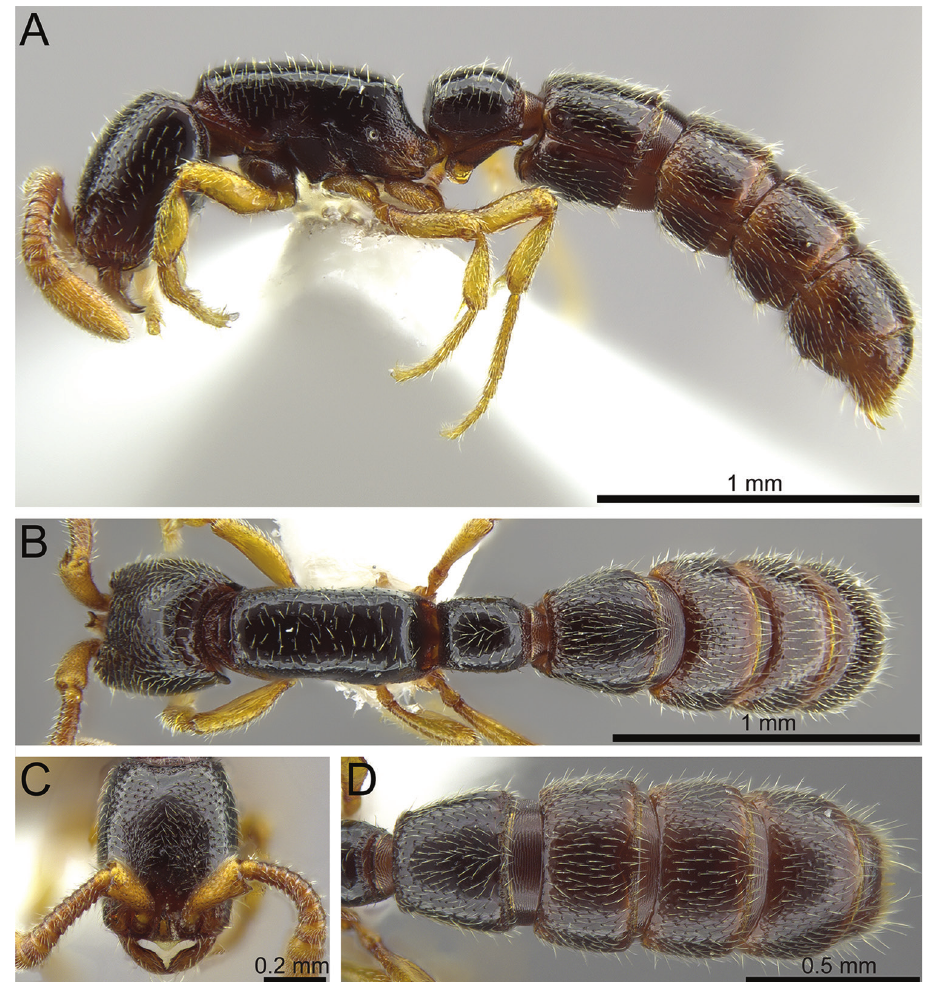
Figure 7. Zasphinctus obamai sp. n. holotype worker (CASENT0764125). A Body in profile B Body in dorsal view C Head in full-face view D Abdominal segments III–VII in dorsal